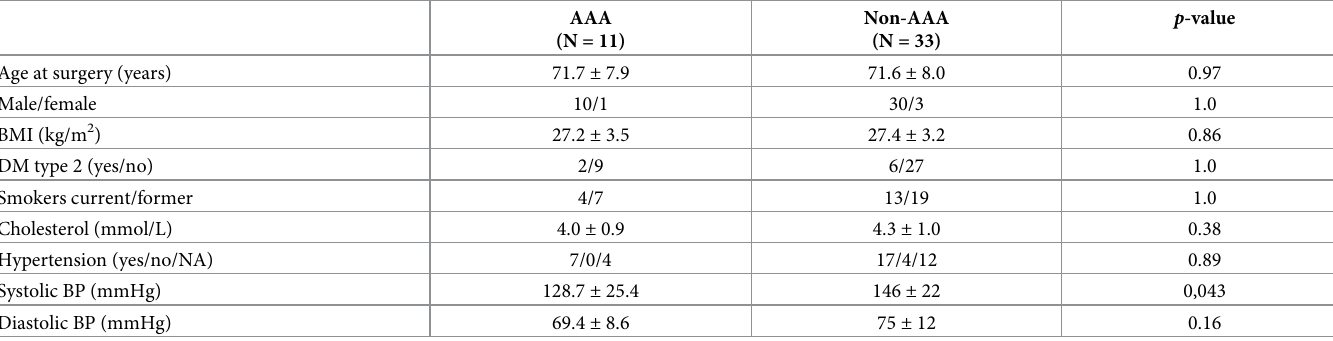
Table 1. Clinical characteristics of patients with abdominal aortic aneurysm (AAA) and patients without abdominal aortic aneurysm